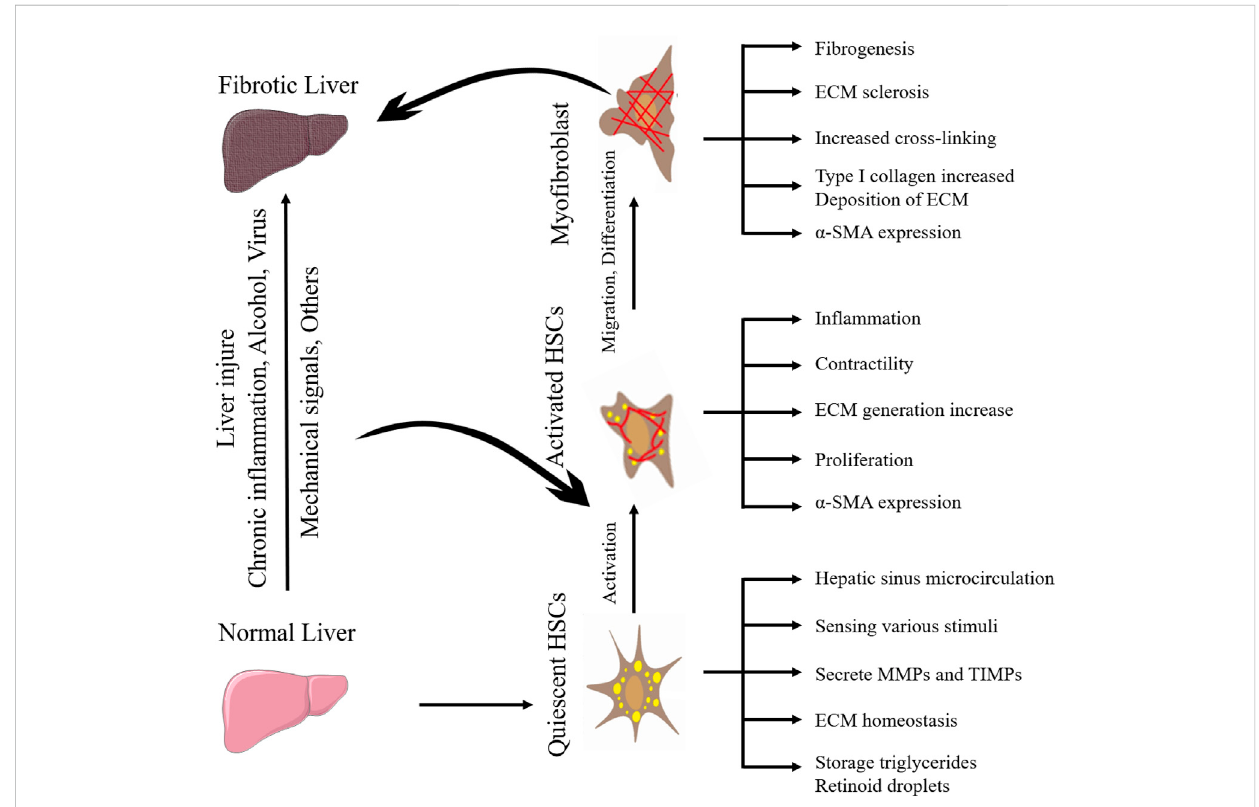
The activation process of quiescent HSCs into myo fi broblasts during hepatic fi